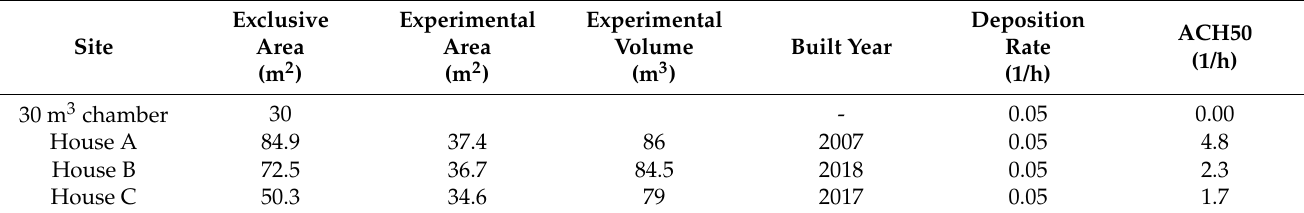
Table 1. Summarized experimental factors by test